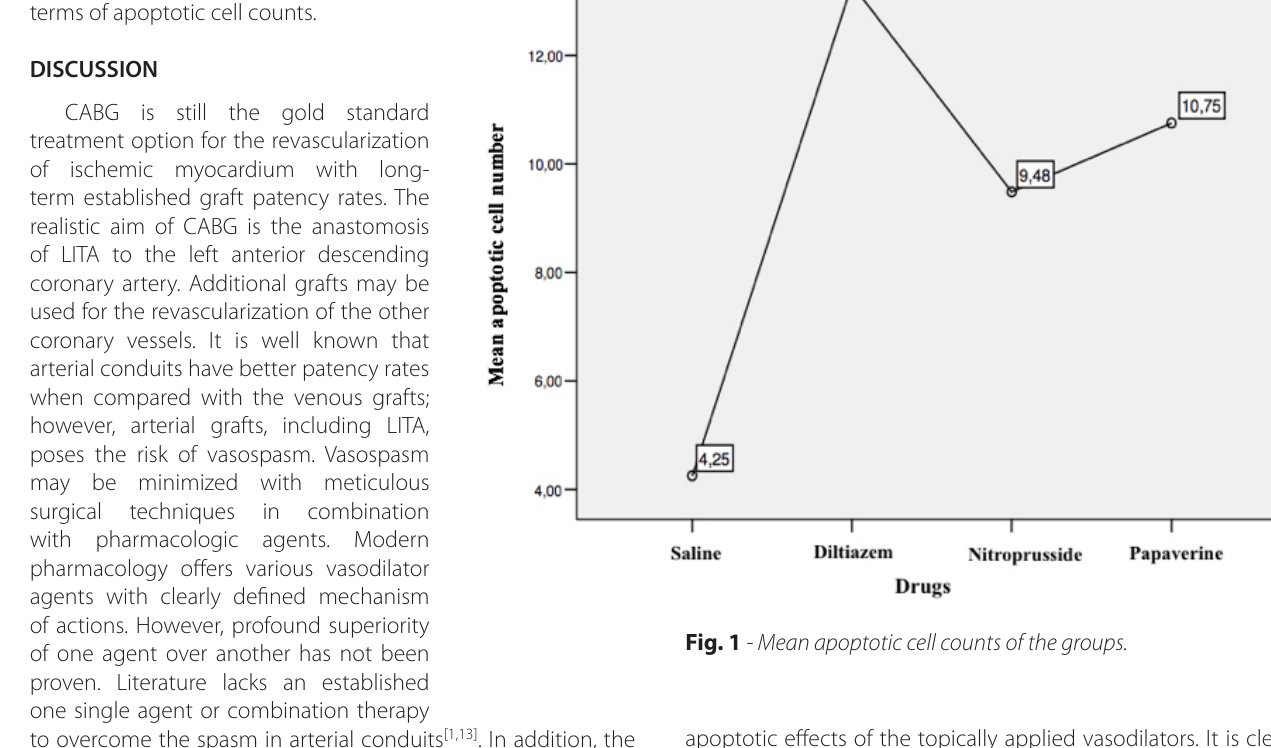
apoptotic effects of the topically applied vasodilators. It is clear that all vasodilators have apoptotic effects to some extent; however, diltiazem was found to cause more apoptosis whereas nitroprusside had the lowest apoptotic effect. The differences between all agents were found to be statistically significant in the current